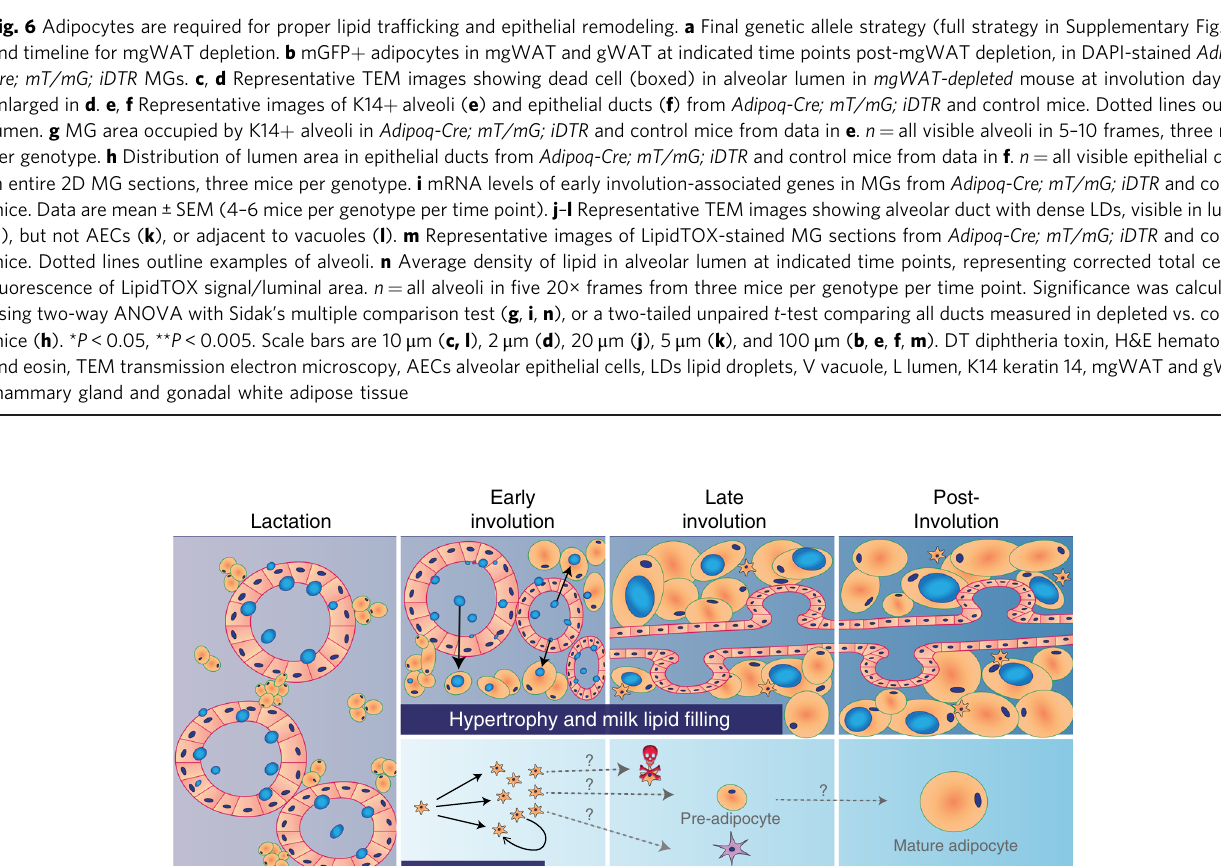
Fig. 6 Adipocytes are required for proper lipid traf fi cking and epithelial remodeling. a Final genetic allele strategy (full strategy in Supplementary Fig. 6a) and timeline for mgWAT depletion. b mGFP + adipocytes in mgWAT and gWAT at indicated time points post-mgWAT depletion, in DAPI-stained Adipoq- Cre; mT/mG; iDTR MGs. c , d Representative TEM images showing dead cell (boxed) in alveolar lumen in mgWAT-depleted mouse at involution day 1, enlarged in d . e , f Representative images of K14 + alveoli ( e ) and epithelial ducts ( f ) from Adipoq-Cre; mT/mG; iDTR and control mice. Dotted lines outline